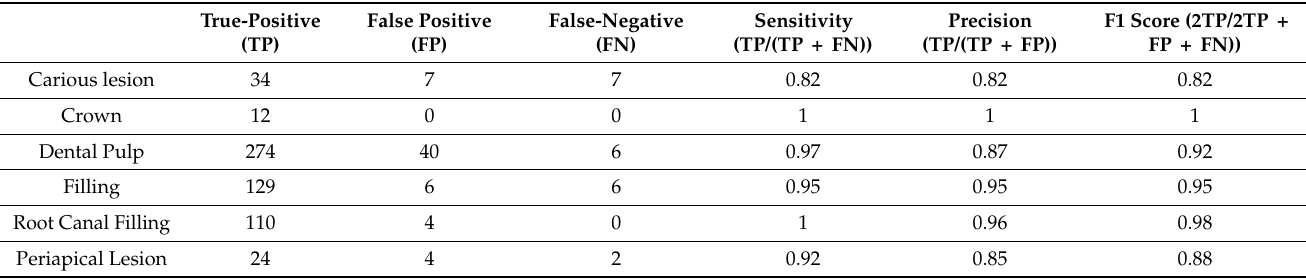
Table 2. Estimated performance measurement based on the AI